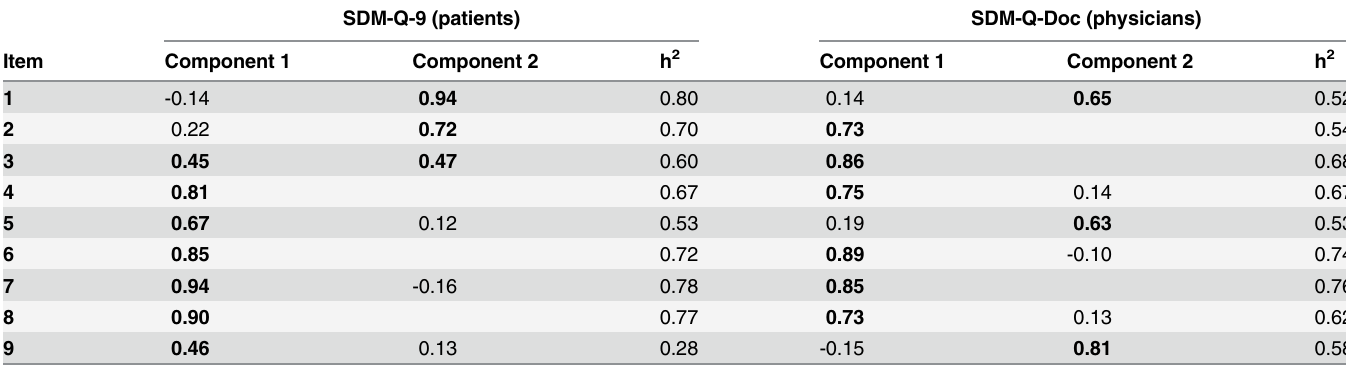
Table 6. Results of the Principal Factor Analysis (PCA) for the SDM-Q-9 and